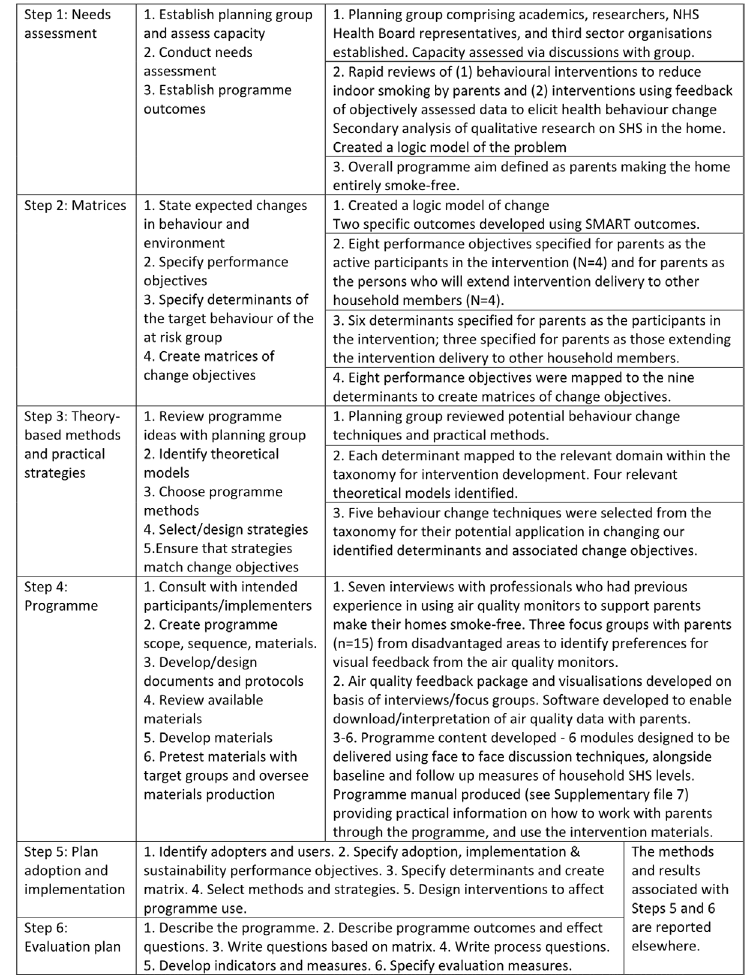
Figure 1: Intervention mapping steps and